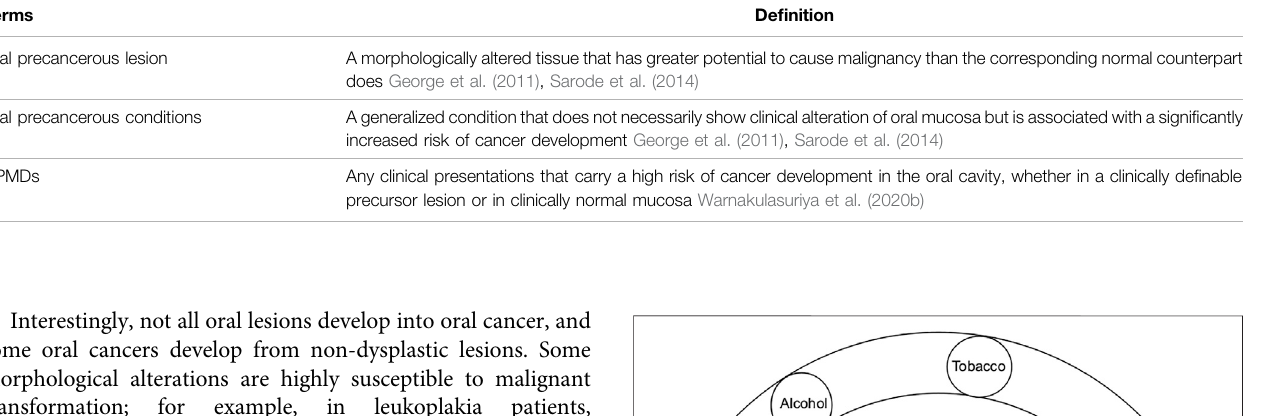
TABLE 1 | De fi nition of terms used for characterization of oral pre-cancer disorders. Terms De fi nition